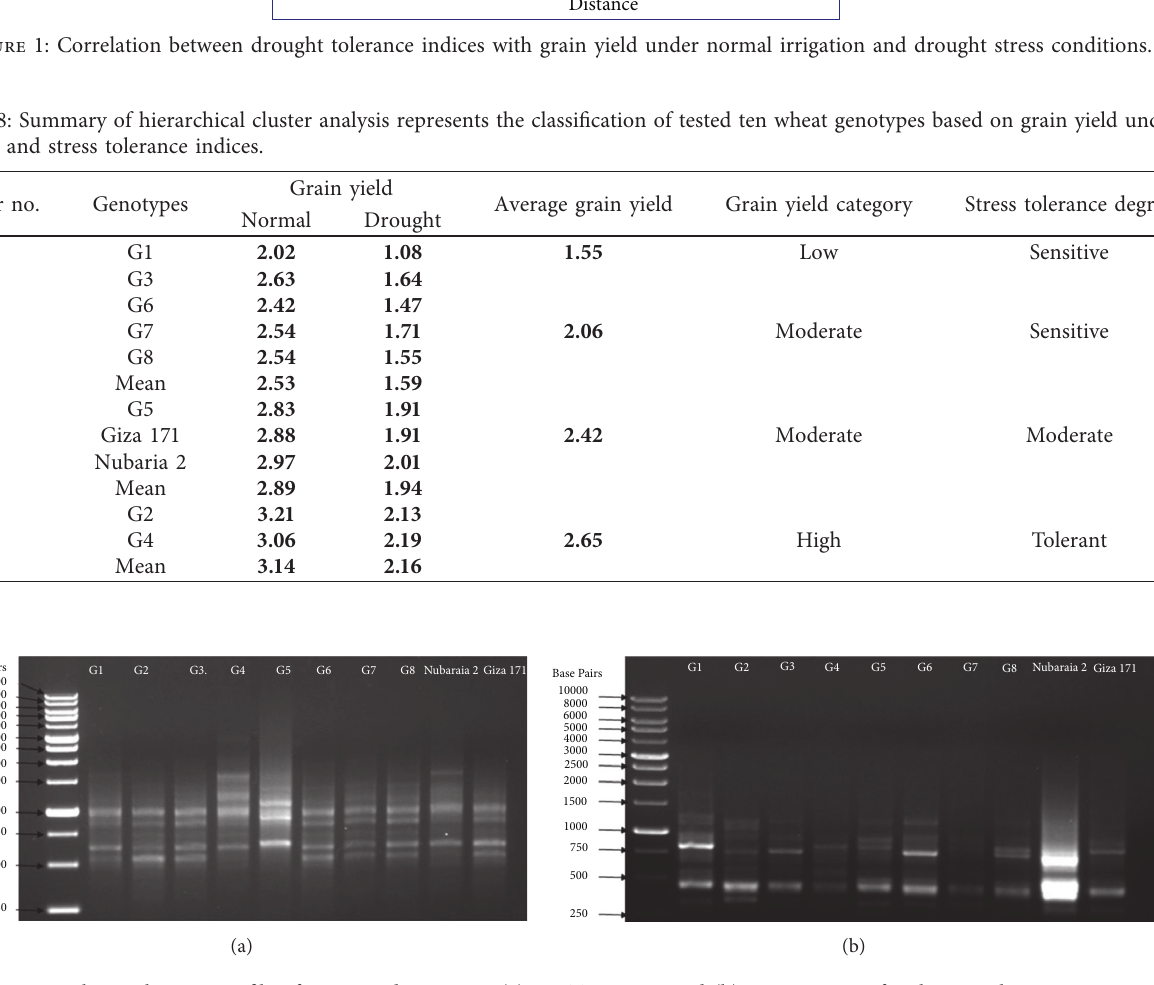
Figure 2: Electrophoretic profile of PCR products using (a) SCoT2 primer and (b) ISSR6 primer for the ten wheat genotypes.